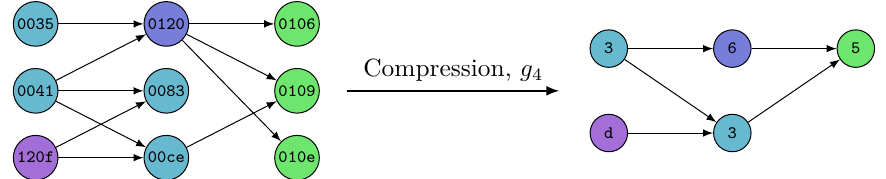
Figure 3: An example of graph compression using the compression function g 4 . The values of the vertices are shown in hexadecimal notation. Vertices in the same stage with non-zero nibbles in the same position are identified, and any multiple edges are